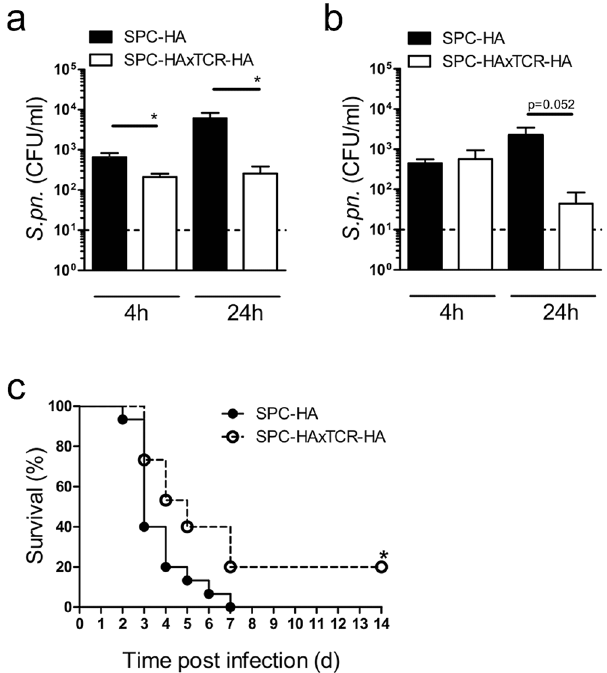
Figure 6. Improved antipneumococcal resistance in pre-diseased SPC-HAxTCR-HA mice. Mice were oropharyngeally inoculated with ~1.5 × 10 4 CFU S . pneumoniae TIGR4 and were sacrificed at the indicated time points. The bacterial burden in bronchoalveolar lavage fluid (BALF) ( a ) and lung tissue homogenates ( b ) was determined. BALF and lung homogenates were taken from the same mice. Data were pooled from 2 independent experiments. Dashed lines indicate the detection limit. * p < 0.05. ( c ) Mice were oropharyngeally inoculated with ~1.5 × 10 6 CFU S . pneumoniae TIGR4 and survival was followed over a period of 14 days. * p < 0.05 (n = 15/group, 2 independent experiments).